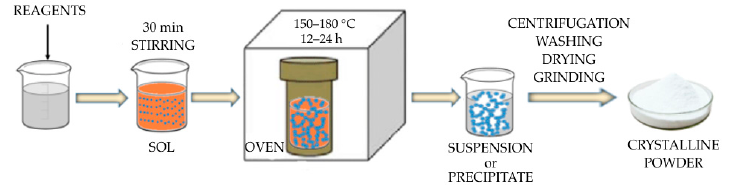
Figure 1. Scheme of the TiO 2 NPs synthesis.